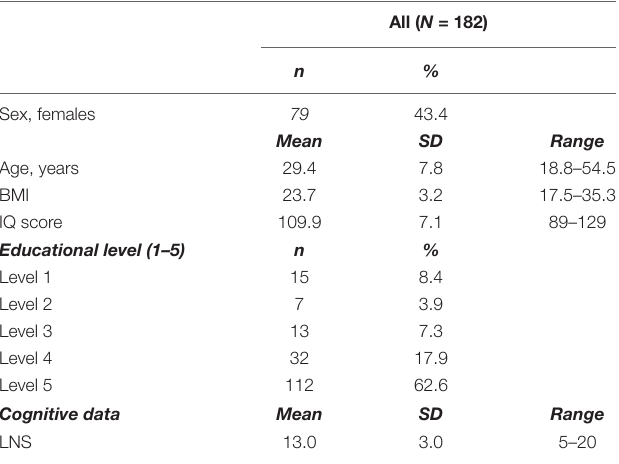
TABLE 1 | Descriptive information for the healthy sample in Part